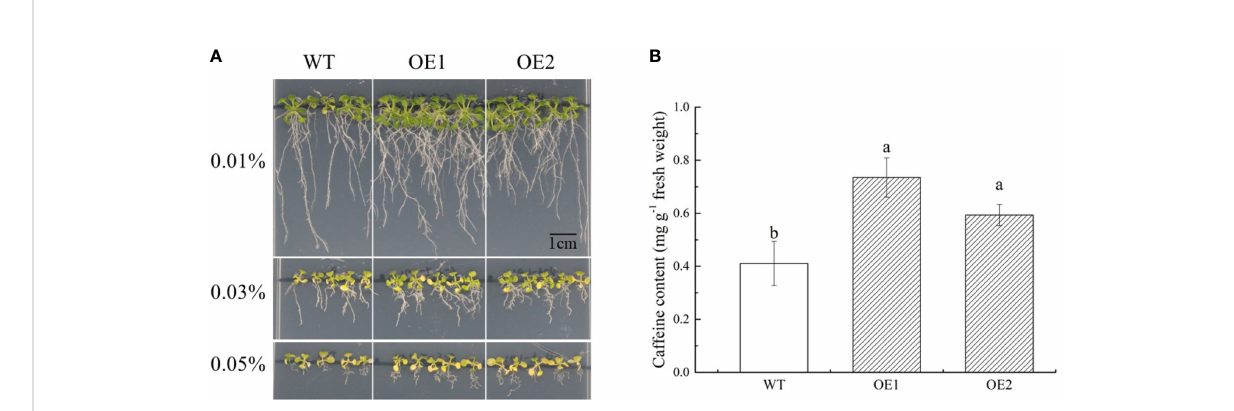
FIGURE 9 Functional identi fi cation of CsPUP10.1 in Arabidopsis. (A) Phenotypic differences of transgenic over-expression (OE) lines and wild type (WT) under caffeine treatments. (B) Caffeine accumulation in Arabidopsis under 0.01% caffeine